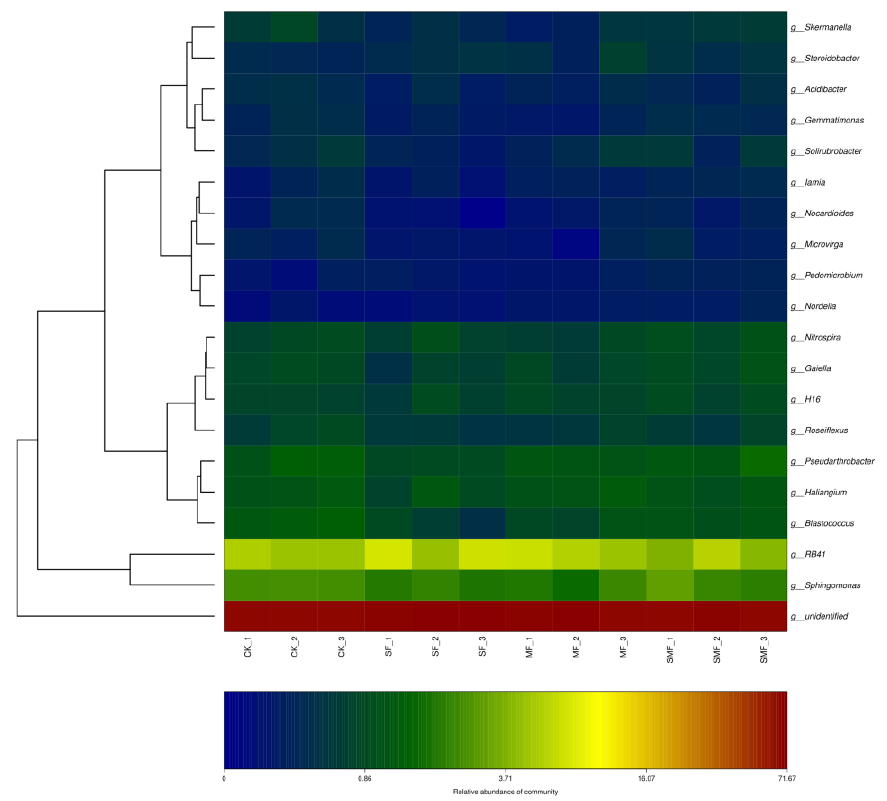
Figure 4. Heat map of soil bacterial community under silicon fertilizer and microbial agent treatment at the genus level.